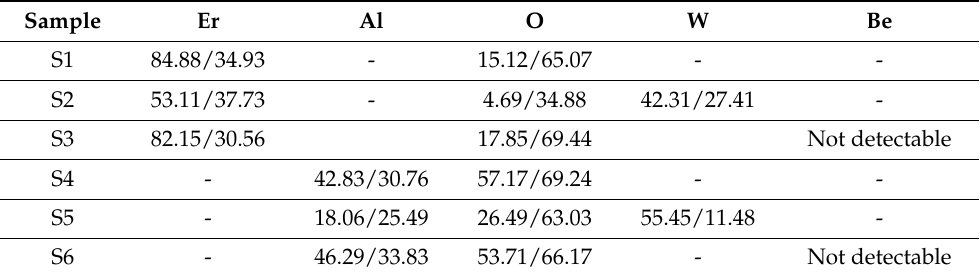
Table 2. EDX composition measurements (wt.%/at.%).